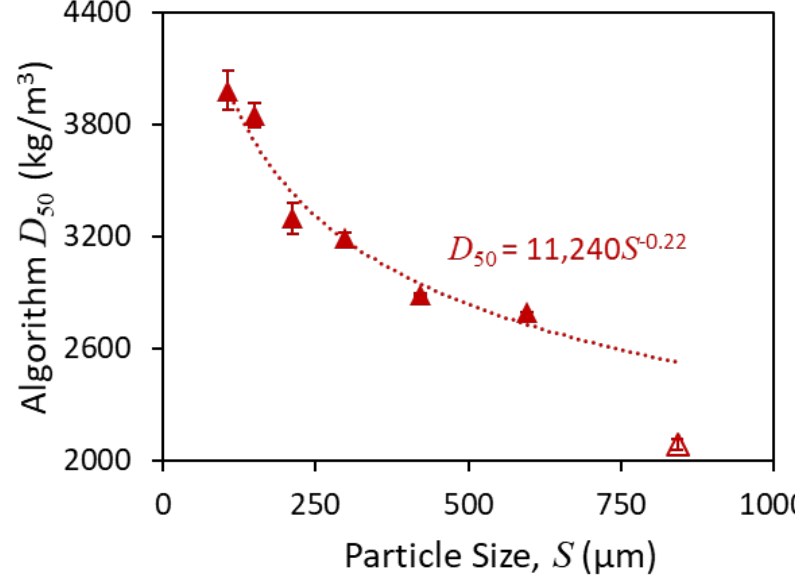
Figure 5. Variation in D 50 as a function of particle size based on applying the algorithm to the LST flow fractionation data. The D 50 varied with particle size to the power − 0.22 when the clear outlier (open triangle) was omitted. RC separation z = 3 mm; RC flow fractionation z = 3 mm.